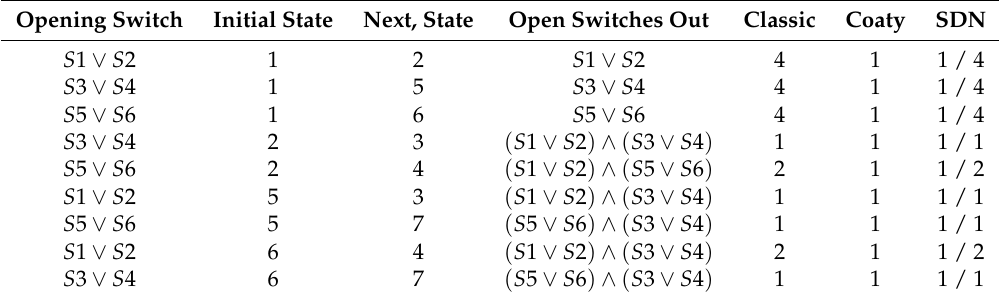
Table 3. State transition table including a reconfiguration action count for state transitions within the different